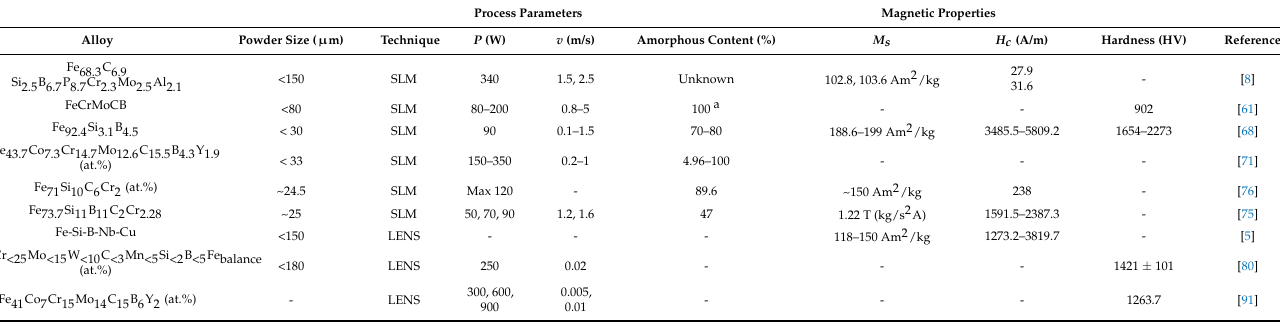
Table 3. Amorphous content, magnetic and mechanical properties of Fe-based alloys produced by laser additive manufac- turing, also showing process parameters and powder size of starting